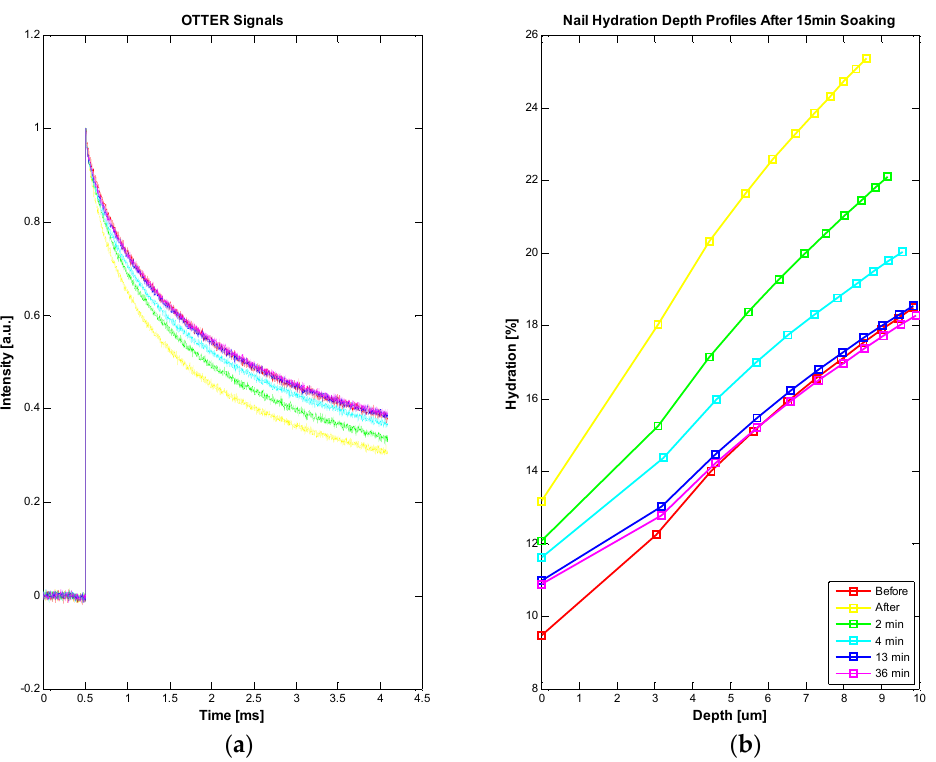
Figure 7. The OTTER signals of in vivo human fingernail ( a ) and corresponding water concentration depth profiles using SLS fitting technique before and after a 15-min soaking ( b ).